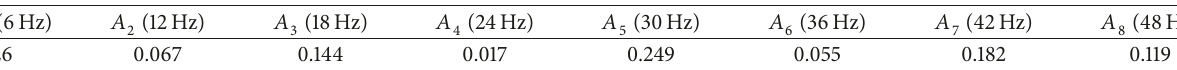
Figure 11: Estimated phase of harmonic. Table 1: Each harmonic’s